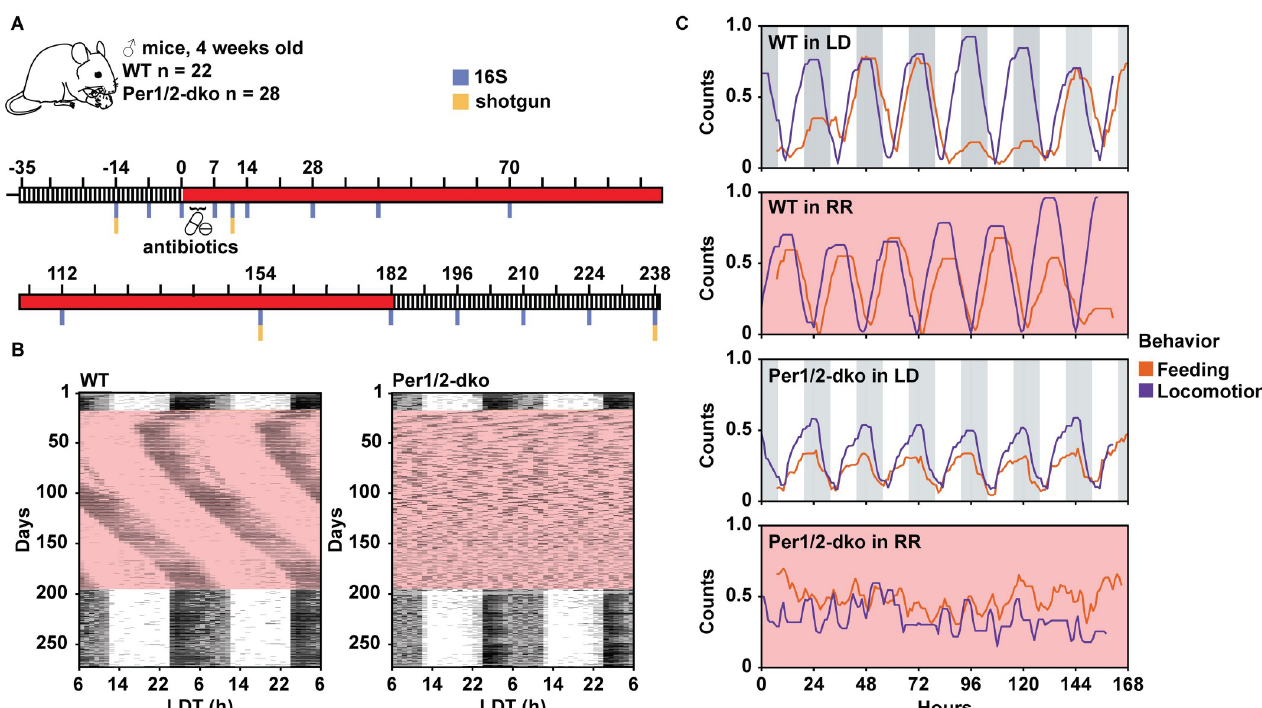
Fig 1. Protocol and characterization of the Per1/2-dko mouse model in RR. (A) The LD/RR/LD regimen of this experiment started with entrainment to LD 12:12 for 35 days, then RR for 182 days, and concluded with a return to LD for an additional 56 days. Black/white stripes indicate LD conditions and red indicates RR. Vertical blue bars indicate the time points of stool collection for 16S sequencing, and the additional yellow bars show the 4 samples that were additionally processed for shotgun sequencing. For the fecal collection samples, there were 22 WT and 28 Per1/2-dko mice, all starting at 4 weeks of age. On the first day of RR (Day 0) and for 5 days thereafter, half of the mice were treated with an antibiotic cocktail in their drinking water ( n = 11 for WT, n = 13 for Per1/ 2-dko). The samples were labeled as: WT(UT) and Per(UT) for the untreated WT and Per1/2-dko groups, respectively, and WT(T) and Per(T) for the groups treated with antibiotics. (B) Wheel-running locomotor activity of singly housed WT and Per1/2-dko mice. The mice used for activity and feeding experiments were a separate group from those used for stool collection, but were exposed to the same regimen as shown in panel A (the data of the 2 mice shown in panel B are representative examples of each corresponding group). Both genotypes of mice were entrained well by LD at the beginning. In RR, WT mice were still rhythmic (left panel), whereas Per mice had severely disrupted patterns (right panel). Both genotypes could still be entrained in LD after the exposure to RR. See S1 Table for statistical analyses and S1 Data File for the data that are analyzed in S1 Table. (C) Feeding and locomotor activities of representative individual mice were recorded for 7 days interspersed throughout the varying LD/RR conditions (see S2 Table). Locomotor activity is represented by the purple lines and the feeding activity shown by orange lines. “Counts” on the ordinate is locomotor activity or feeding behavior events organized in 1-h bins and normalized as described in Methods. See for statistical analyses and S1 Data File for the data that are analyzed in S2 Table. LD, light/dark; Per1/2-dko, Per1/Per2 double knockout mice; RR; red light; WT, wild-type